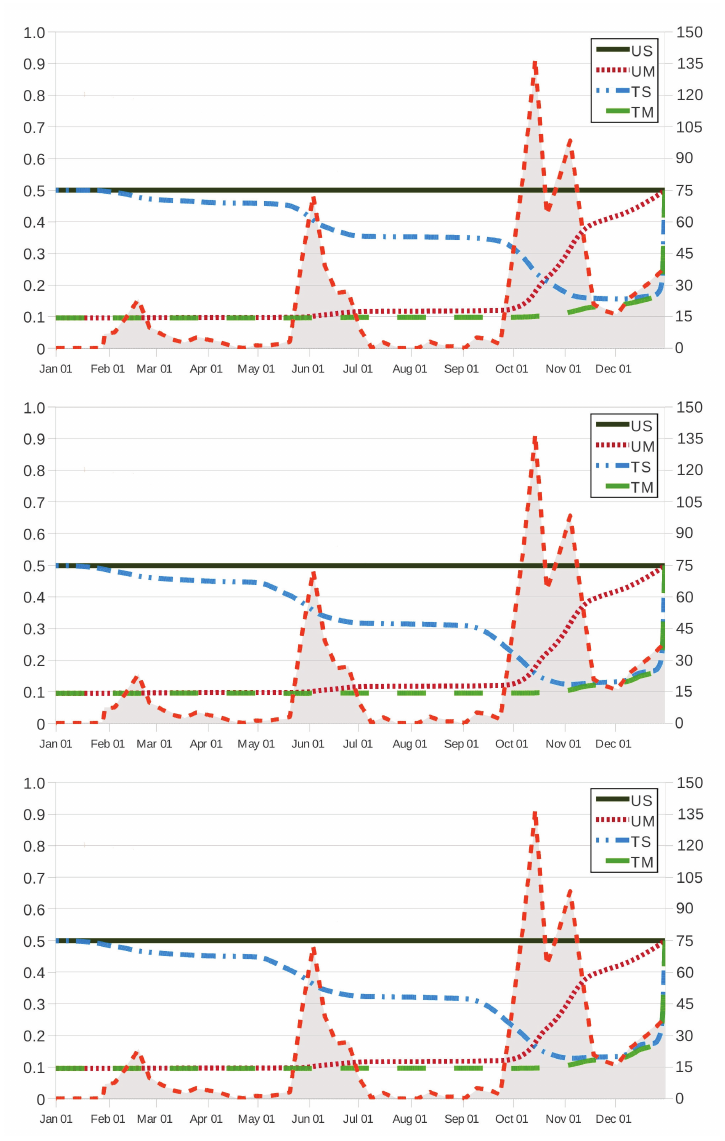
Figure 3. Cost cost s ( t 0 ; τ ) of intervention as a function of the intervention age t 0 for τ = 1 year and increments in the number of L 3 infective larvae in the small intestine (shaded area, right vertical axis). Scenario US, and grazing strategies UM, TS and TM with the anthelmintics ivermectin, fenbendazole and albendazole (from top to